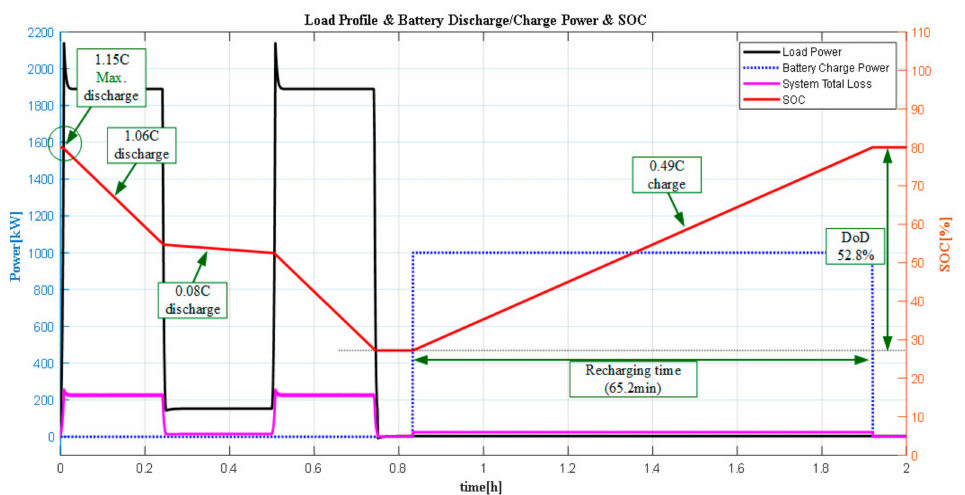
Figure 29. BESS charge/discharge profile reflecting the entire system loss according to the opera- tion profile.